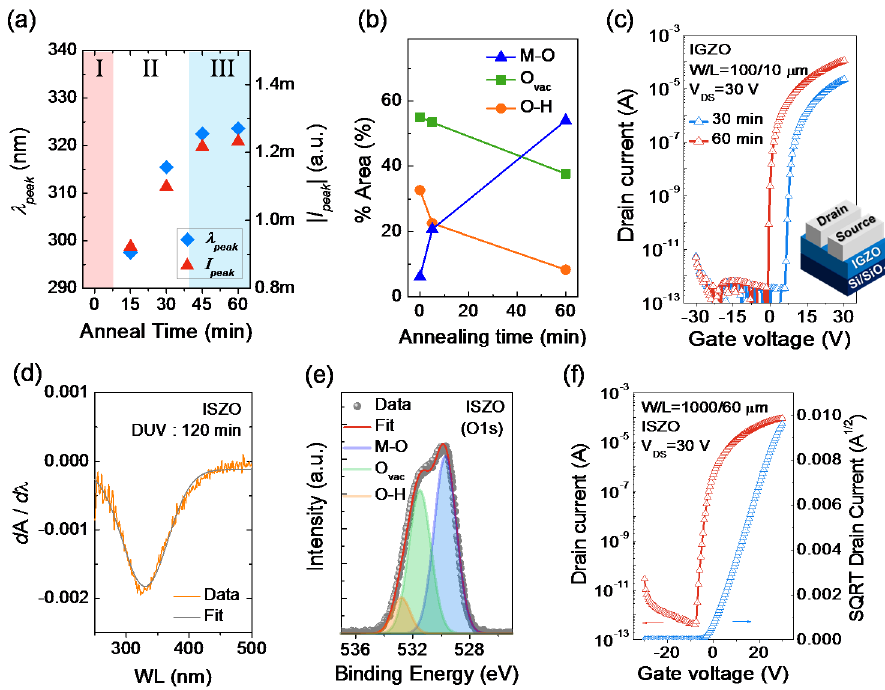
Figure 5. ( a ) The variation of peak center ( λ peak ) and peak intensity ( I peak ) as a function of photo ‐ activation time: regime I — no peaks, regime II — increasing λ peak and I peak , and regime III—saturation of λ peak and I peak ; ( b ) The changes in the binding states of oxygen atoms (represented as area %) in an IGZO film as a function of photo ‐ activation time; ( c ) Transfer characteristics of IGZO TFTs with different photochemical activation time (30 min, 60 min); ( d ) A ʹ ‐λ plot for the 120 ‐ min ‐ annealed ISZO film; and ( e ) the O 1 s peak from the XPS spectra of the ISZO film; ( f ) Transfer characteristics of photo ‐ activated ISZO TFTs (120 min).